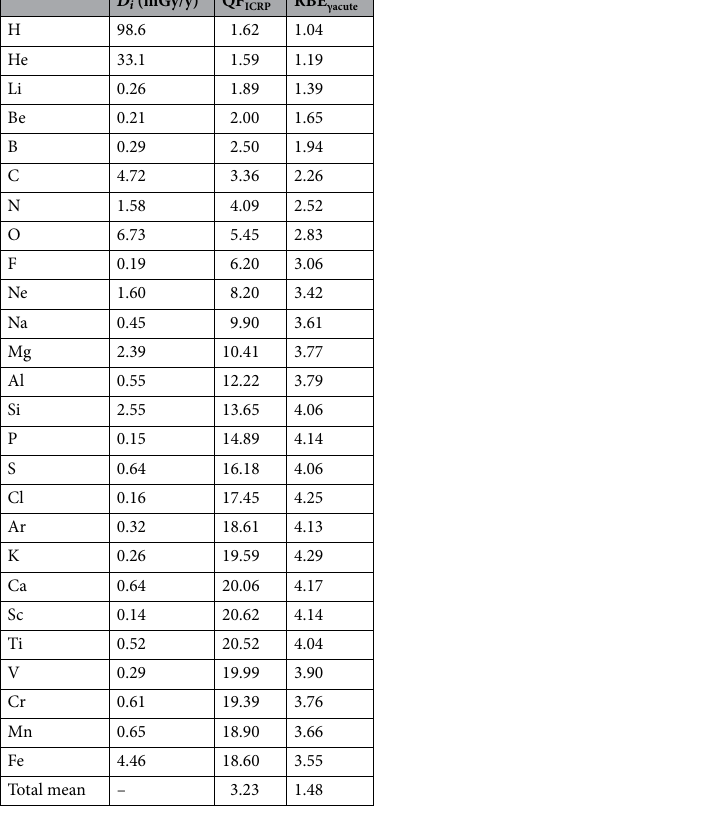
Table 1. Absorbed dose rates and mean QF ICRP and RBE γacute of GCR elements in free space (with no shielding